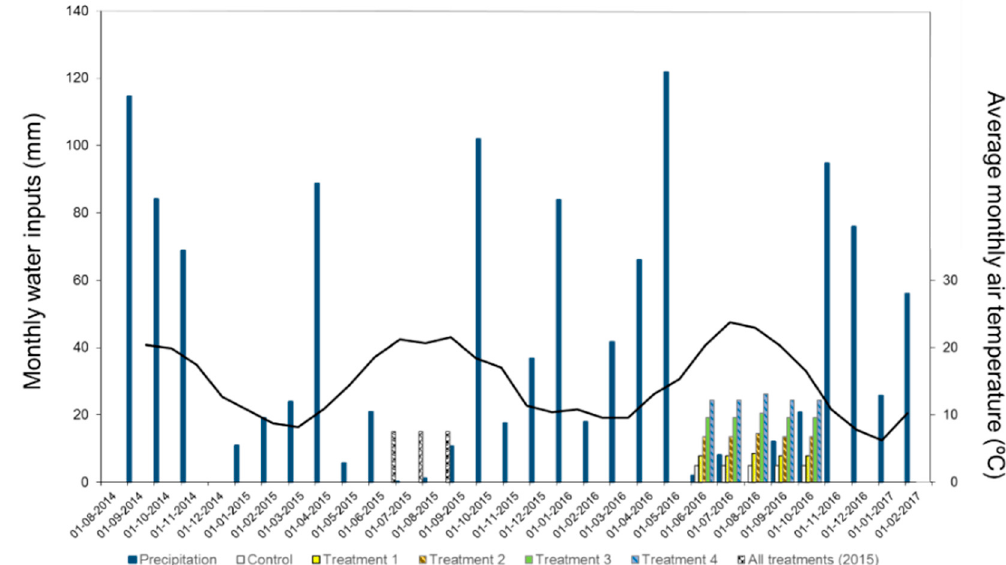
Figure 2. Ombrothermic chart of monthly rainfall and mean temperature that occurred in the experimental plot since planting, including monthly irrigation water inputs per treatment. Control received survival irrigation.